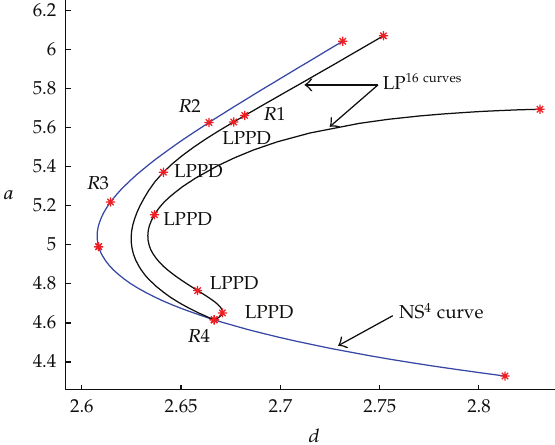
Figure 12: Twofold curves (cid:3) LP 16 (cid:4) emanate from an R4 point on the NS 4